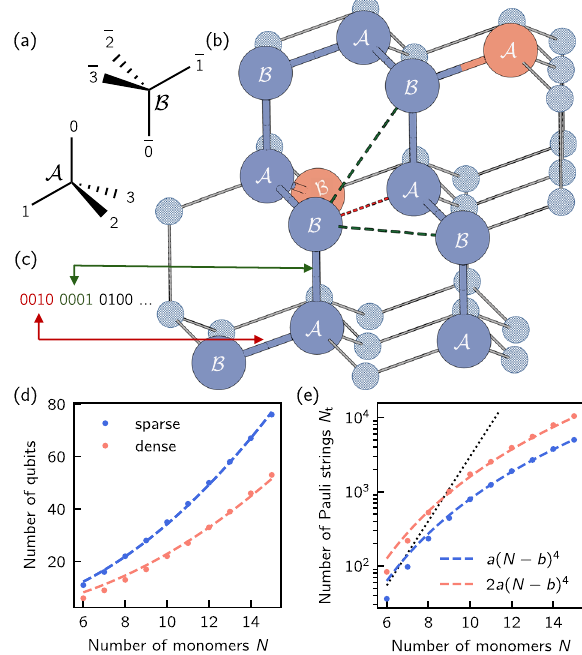
Fig. 1 Tetrahedral lattice polymer model. a Labeling of the coordinate systems at the sub-lattices A and B . b Typical polymer conformation (10 monomers). The red and dark green dashed lines represent a subset of inter-bead interactions considered in our model. Side chain beads are shown in orange. c Example of turn encoding. d Number of qubits required by the sparse (3-local terms) model (blue) and its dense (5-local terms) variant (orange) as a function of the number of monomers. e Number of Pauli strings with respect to the number of monomers for the sparse and dense encoding models. The parameters of the fi t are ( a , b ) = (0.15, 1.49). The exponential curve (dotted line) is given as a